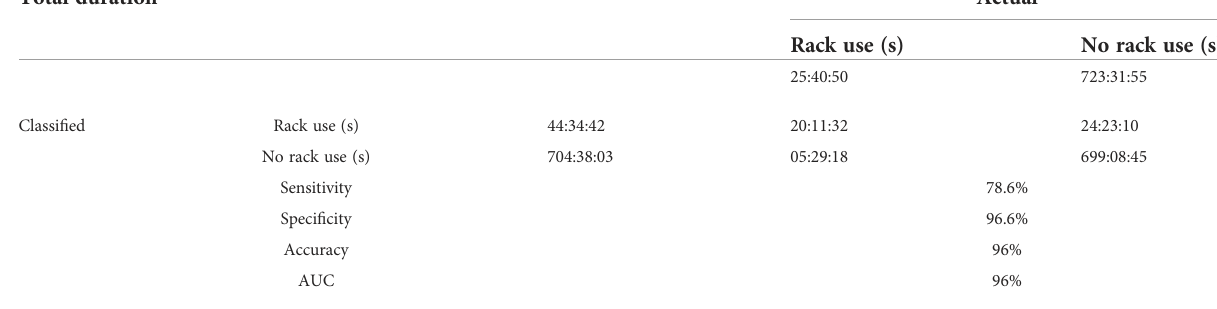
TABLE 3 Confusion matrix of RF classi fi cation of hay rack use in the validation set. Total